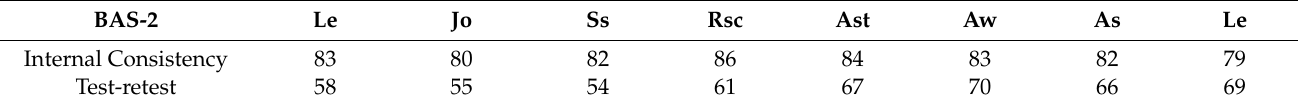
Table 2. Reliability presented in the BAS-2 manual.